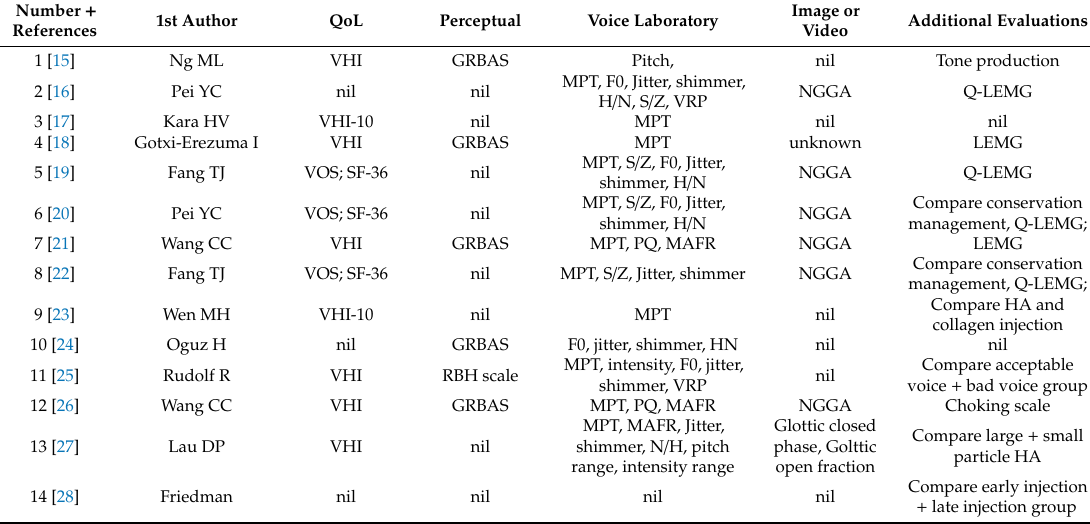
Table 3. Summary of the evaluations before and after hyaluronic acid injection laryngoplasty for unilateral vocal fold paralysis in reported